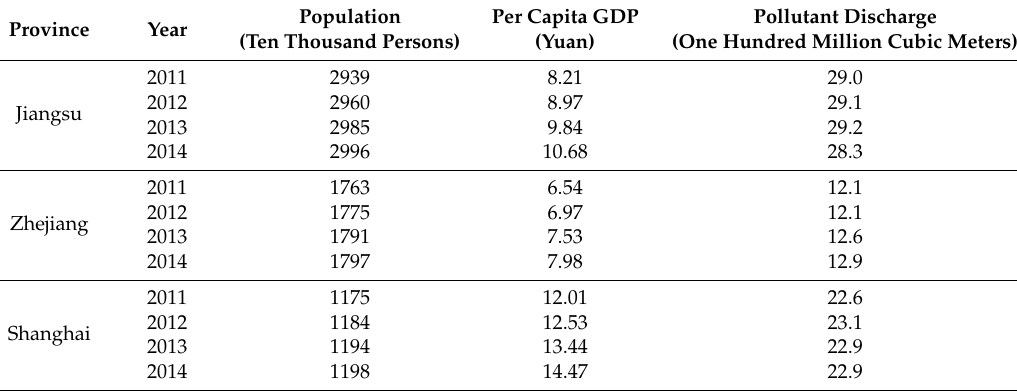
Table 1. The index values of the provinces in the Taihu Basin from 2011 to 2014.